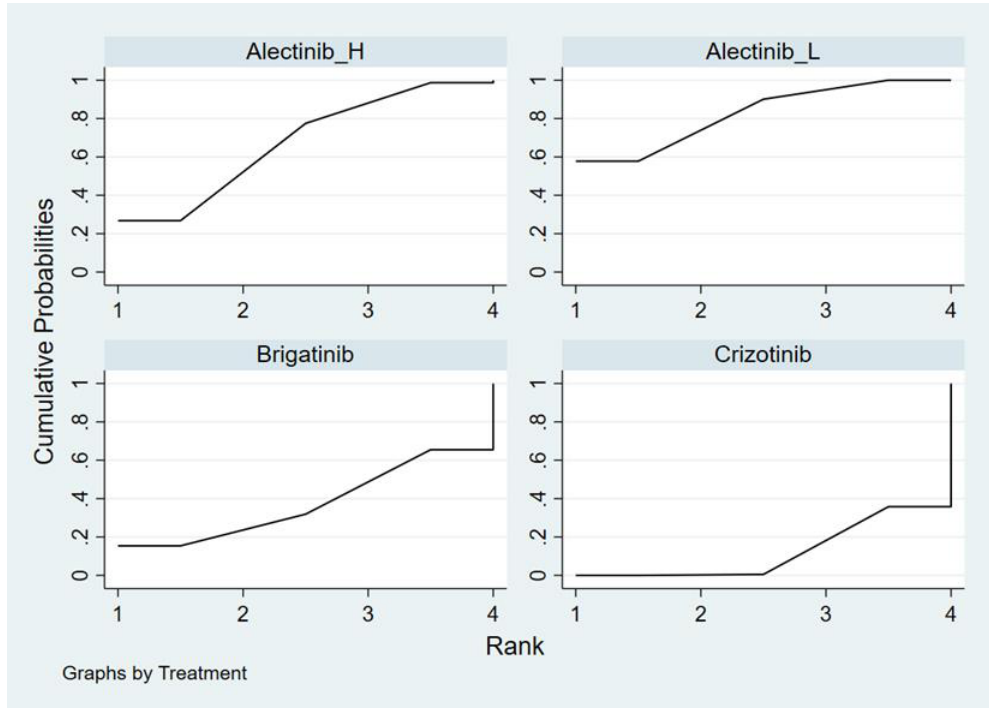
Figure A5. Cumulative ranking probability for objective response rate (ORR).